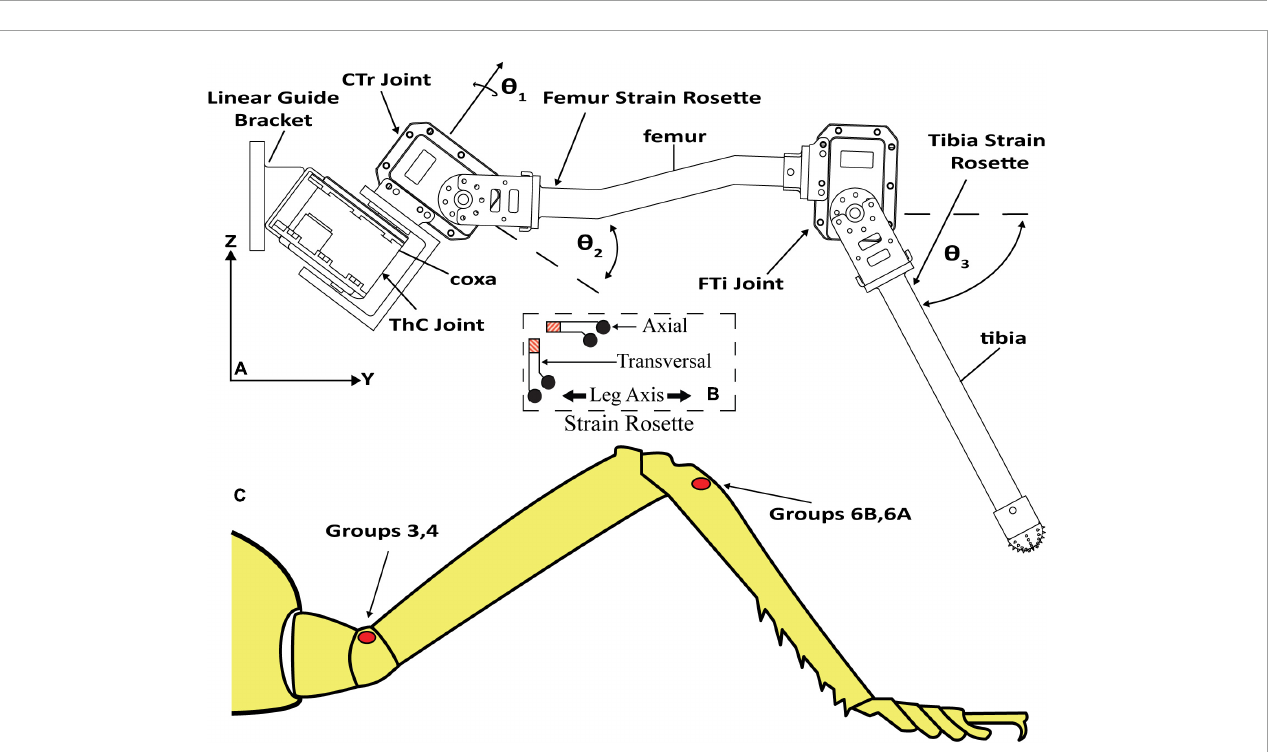
FIGURE2 (A) C. morosus robotic middle leg with three degrees of freedom. The leg segments, joint axes, and joint angles are indicated. The strain gauge rosettes are labeled on the tibia and trochanterofemur. (B) Strain gauge rosette inset, which displays orientation, is relative to the long axis of the leg segment. (C) CS groups which are labeled on an illustration of a C. morosus